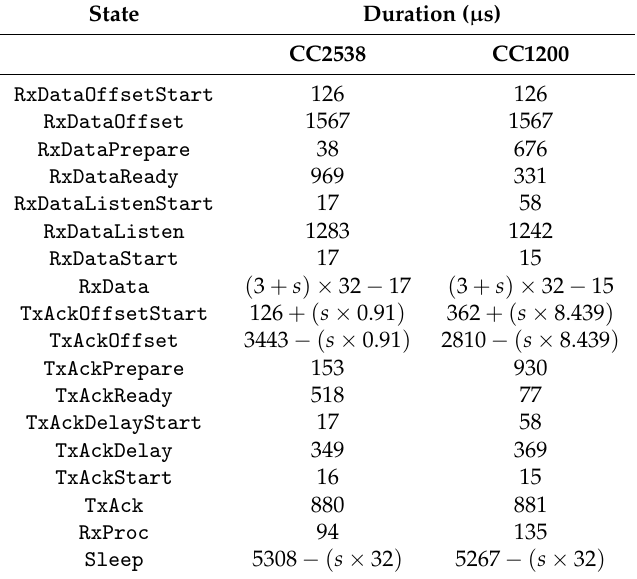
Table 11. State durations in the RxDataTxAck time slot with a total length of 15ms and s being the packet size in bytes.